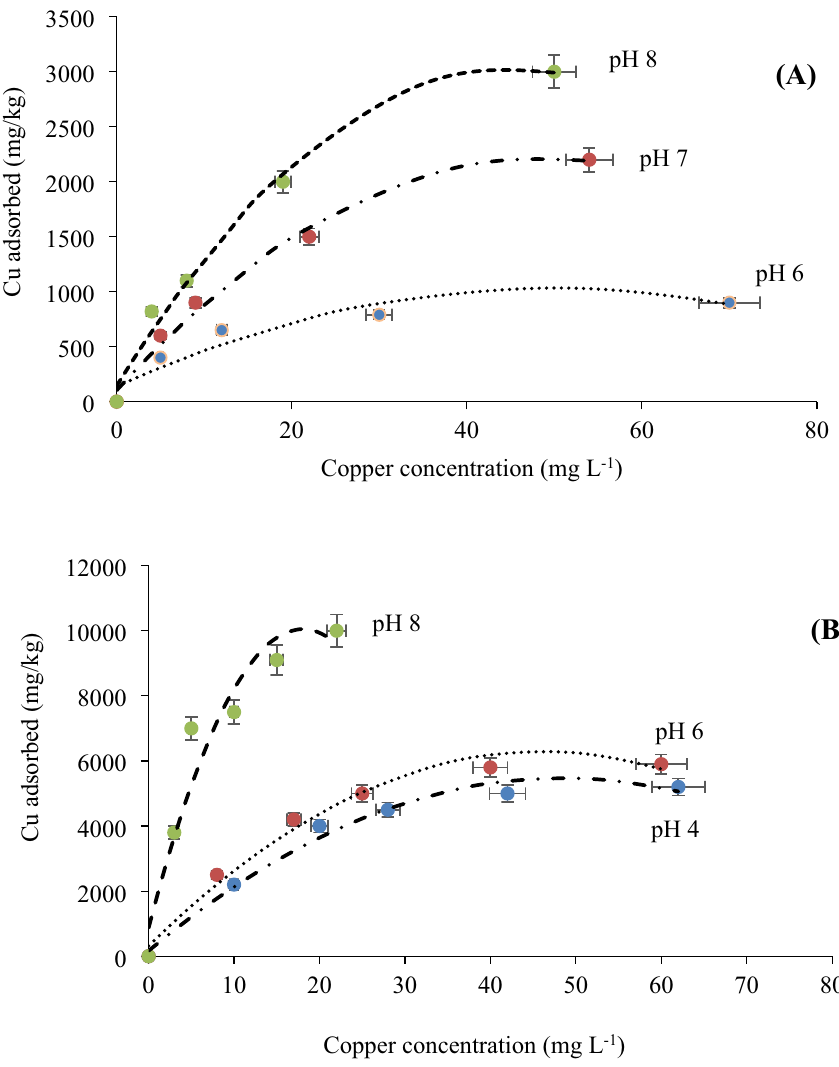
Figure 6. Effect of pH on Cu(II) adsorption by (A) γ-Al 2 O 3 , and (B) TiO 2